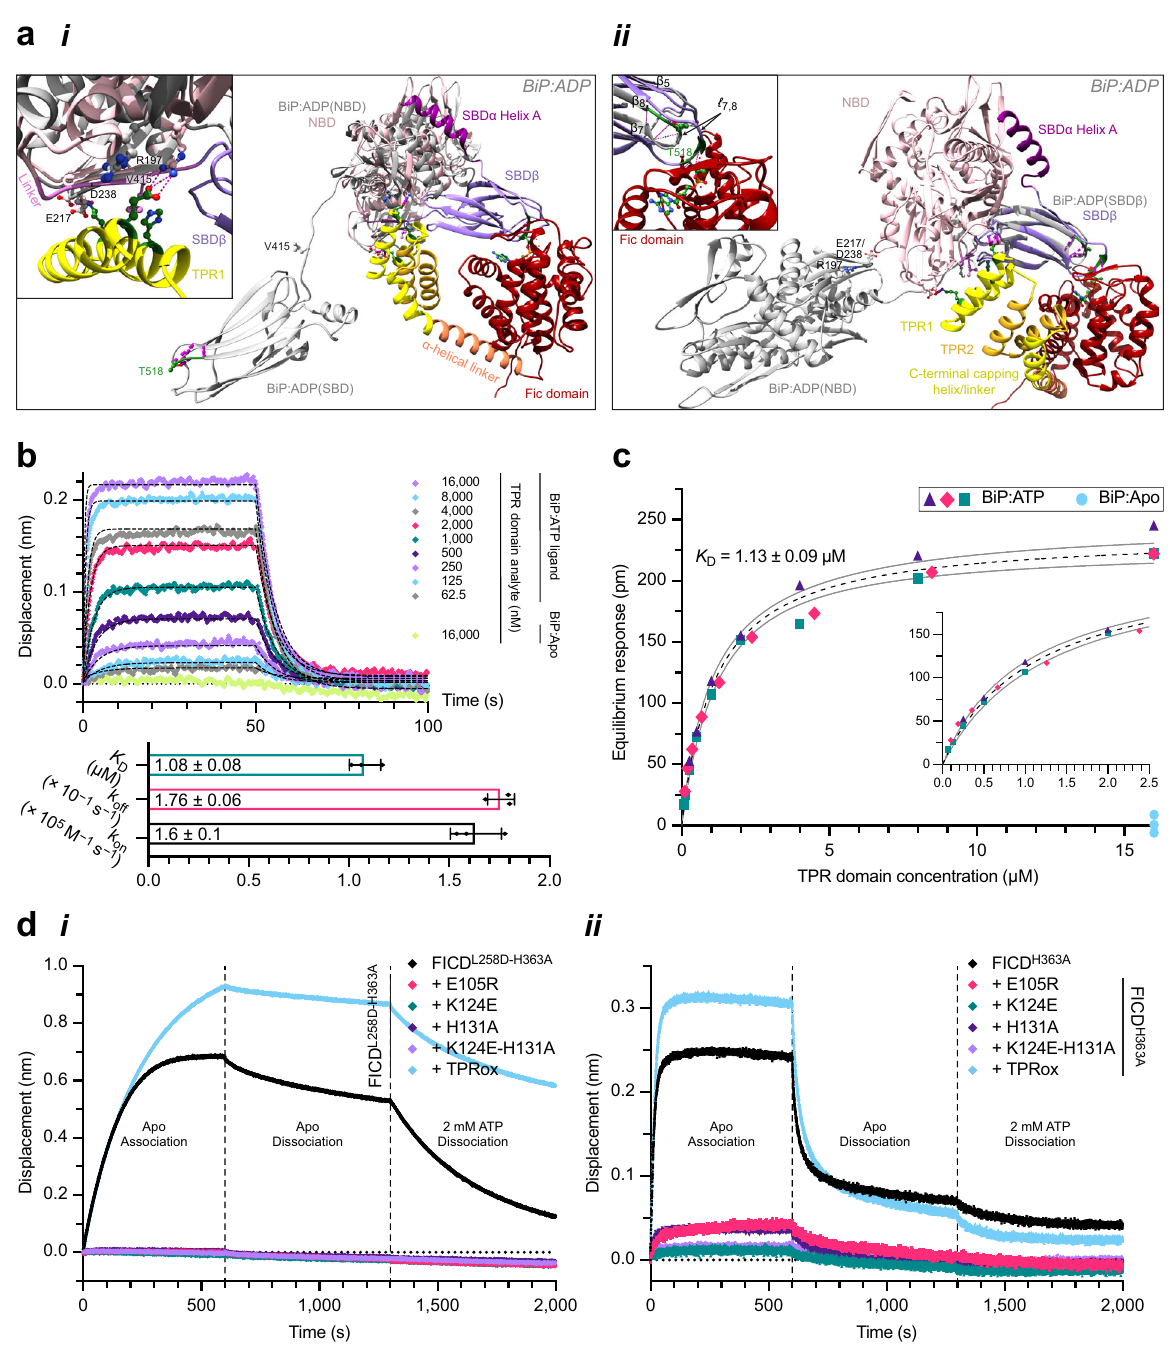
Fig. 4 FICD ’ s TPR domain is essential for the recognition of ATP-bound unmodi fi ed BiP. a The deAMPylation complex (coloured as in Fig. 1a with selected BiP interaction partners labelled) is aligned via its NBD ( i ) or SBD β ( ii ) with an ADP-state BiP (PDB 7A4U; grey) 72 . Inset ( i ), a closeup view of FICD(TPR1)-BiP(NBD) contacts. ( ii ) the intermolecular β -sheet region of ℓ 7,8 (green) is shortened in BiP:ADP. Inset, disposition of Thr518 is highlighted (pink lines; hydrogen bonds). See Supplementary Movie 2 and Supplementary Fig. 6a. b FICD ’ s isolated TPR domain speci fi cally binds the ATP-state of BiP. A representative BLI experiment demonstrating the ability of FICD(TPR) to engage immobilised BiP:ATP but not BiP:Apo. A global fi t analysis of a one- phase association – dissociation model (black dashed lines) is overlaid. Below are the resulting kinetic binding parameters (mean ± SD) of the interaction of FICD(TPR) and BiP:ATP, from n = 3 independent experiments. c Steady-state equilibrium binding response analysis of the representative TPR domain binding experiment shown in b . Results from the analyte dilution series from the three independent BiP:ATP binding experiments are represented by different symbols. The fi t from a one site binding model is shown with 95% con fi dence bands (dashed black line and solid grey lines, respectively). The calculated K D is also annotated (mean ± SD). The inset panel highlights the same data and fi tting over the lower analyte concentration range. Note, the lack of detectable steady-state binding of the TPR domain to BiP:Apo. d Representative BLI analysis of TPR domain mutants of monomeric ( i ) and dimeric ( ii ) FICD binding to immobilised ATP-bound BiP, from n = 3 independent experiments. See Supplementary Fig. 6b. Source data are provided as a Source Data fi